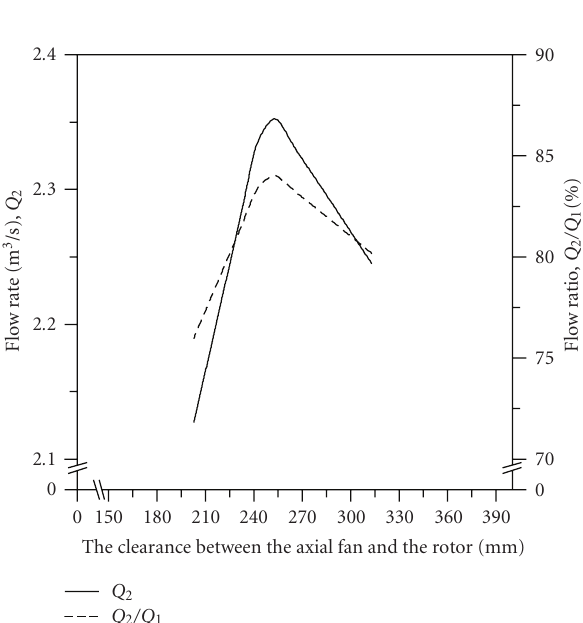
Figure 9: E ff ect of the clearance between the rotor and the axial fan to flow rate Q 2 and flow ratio Q 2 /Q 1